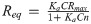
Req results from surface plasmon resonance and the curving fitting of ligand p1, p2 and p3 to Shank1 PDZ protein (Figure A, B, and C for ligand p1, p2 and p3 respectively).Fitting followed the steady state affinity model using this equation: Req=KaCRmax1+KaCn here Req referred to response on the sensorgrams in the steady state region of the curve, C was concentration of analyte, Rmax was the theoretical binding capacity, n = 1 in 1:1 binding model, Ka was association constant, and Kd could be obtained through 1/ Ka.